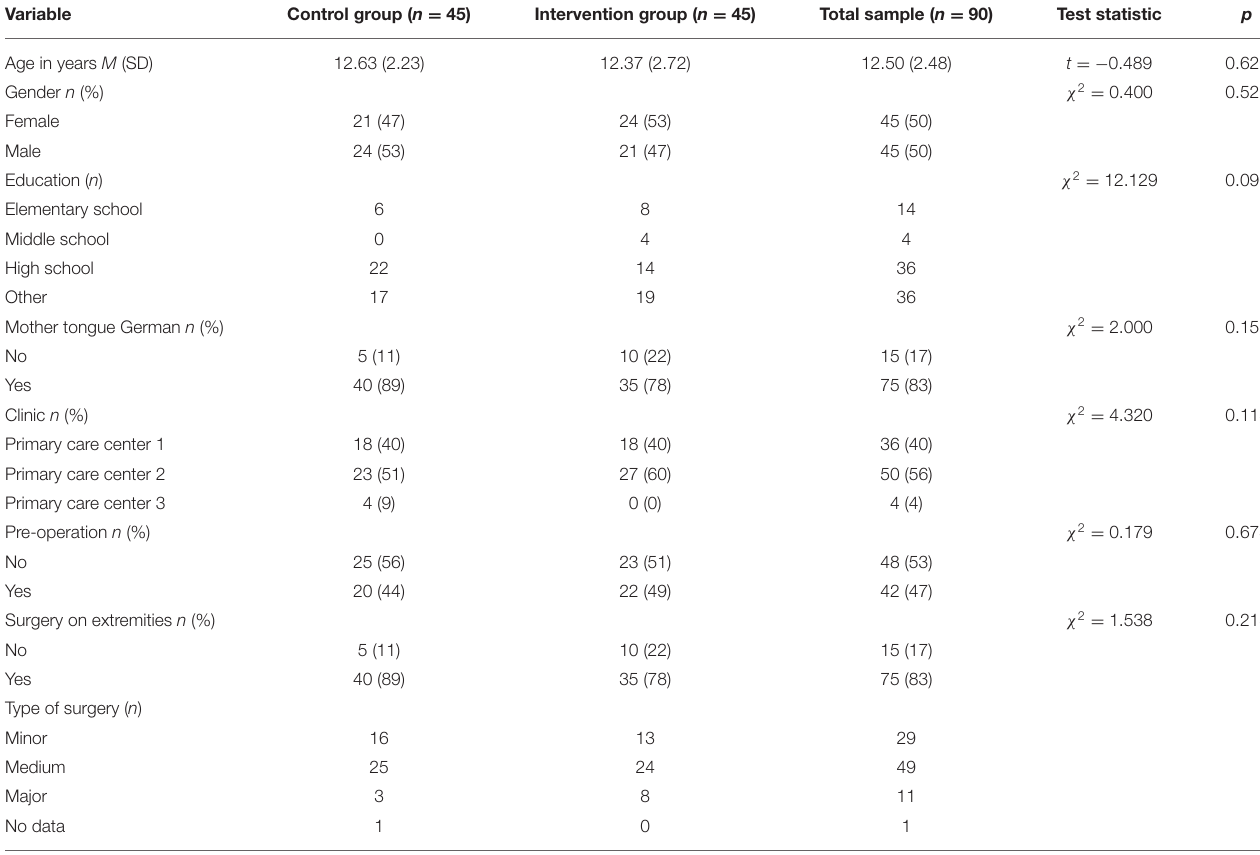
TABLE 1 | Sample description.